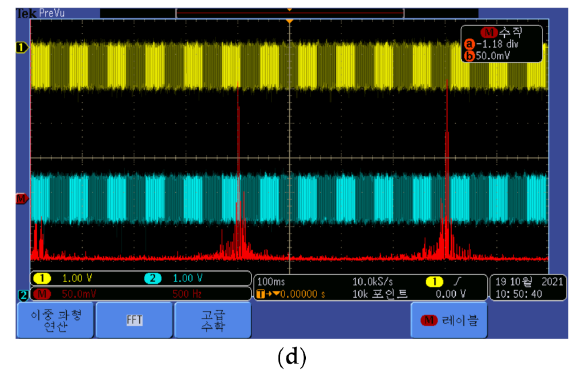
Figure 25. Response characteristics according to the number of PV modules and the operating conditions (high side): ( a ) 1 module and good irradiation; ( b ) 2 modules and good irradiation;